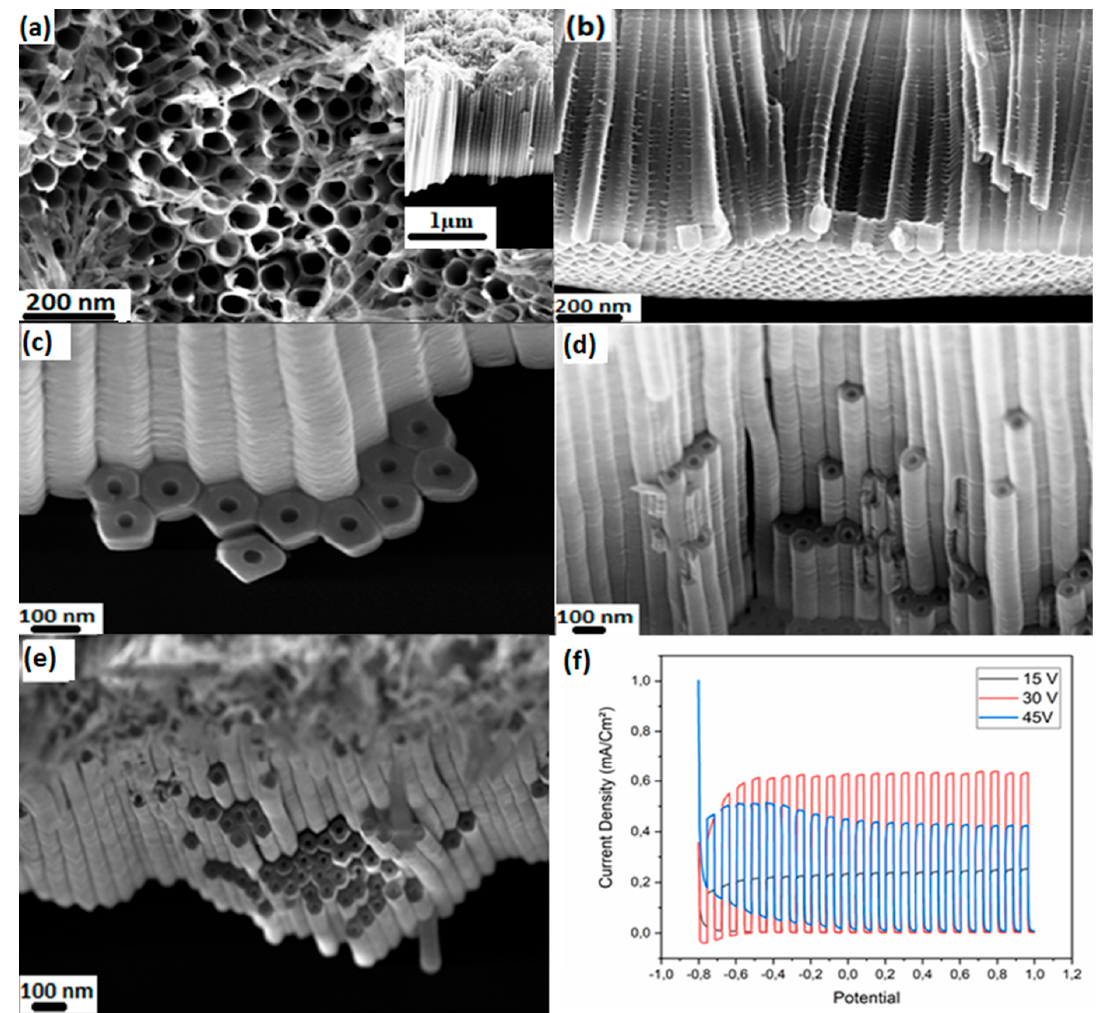
Figure 7. FESEM cross-section images of the TiO 2 nanotubes prepared under different anodization potentials, ( a ) 15, ( b ) 30, ( c ) 45, ( d ) 55 and ( e ) 65 V. ( f ) Current transient of the TiO2 nanotubes prepared under different anodization potentials. (samples prepared using constant electrolyte concentration (0.8 wt% NH 4 F) and anodization time (30 min).